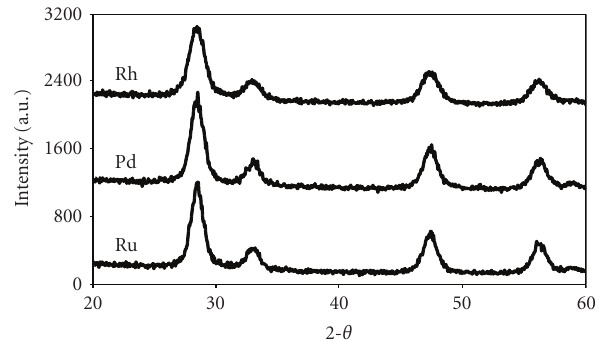
Figure 2: XRD signatures of virgin monometal supported catalysts (calcined: 700 ◦ C/2h).